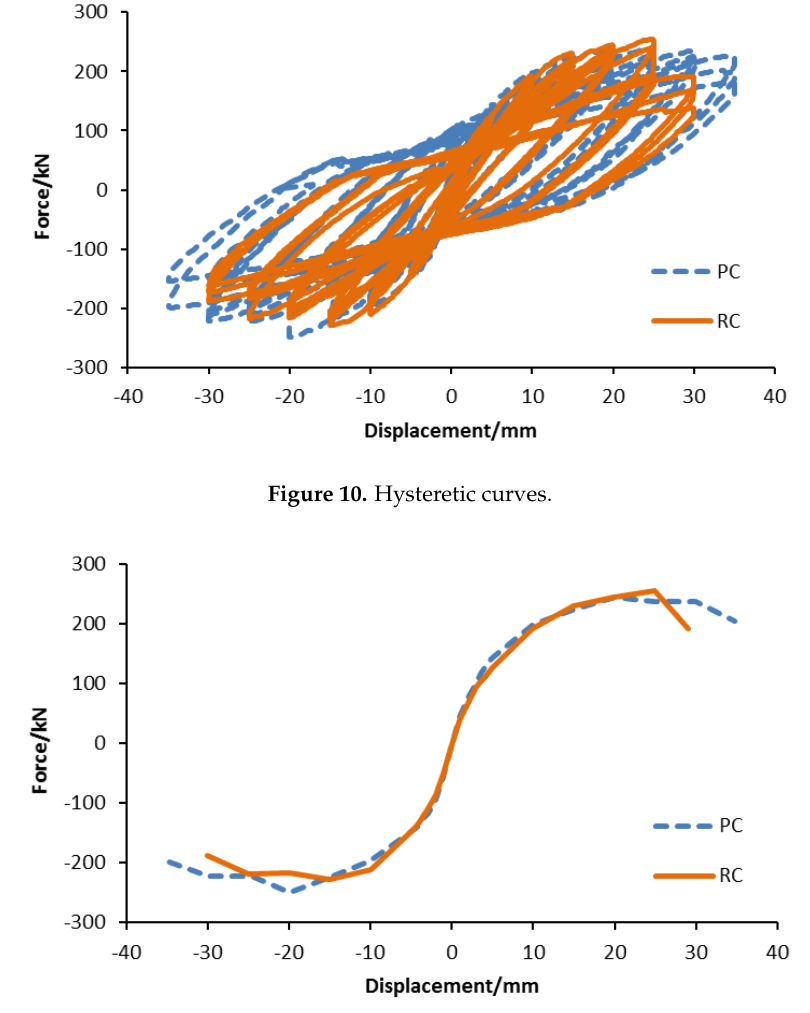
Appl. Sci. 2018 , 8 , x FOR PEER REVIEW